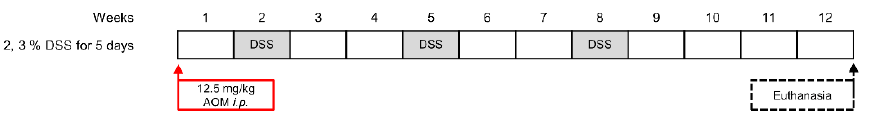
Figure 4. Schematic representation of the CAC induction protocol. In total, 12.5 mg/kg azoxymethane (AOM) were i.p. injected into the mice at the start of the protocol. In the second, fifth and eighth week, the drinking water of the mice was supplemented with 1, 2, or 3% ( w / v ) dextran sulphate sodium (DSS) for 5 consecutive days. 12 weeks after the AOM injection, the mice were euthanized.